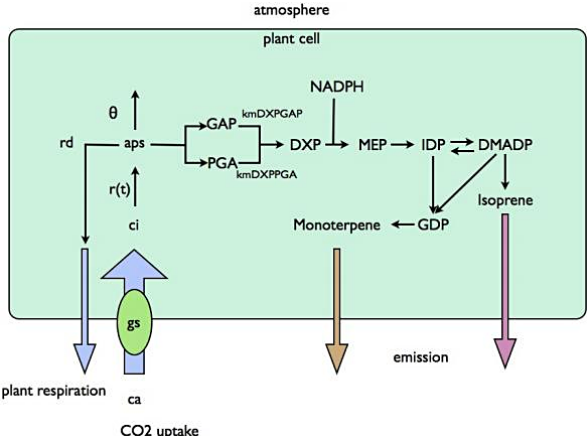
Figure 1. Reaction pathways of the SIM–BIM emission model. Here, C a is CO 2 concentration in the air; C i is intercellular CO 2 concentration; g s is stomatal conductance; A ps is assimilated car- bon pool; r(t) is photosynthesis rate as a function of light; r d is dark respiration rate; θ is the fraction of carbon used in a plant’s metabolism; kmDXPGAP and kmDXPPGA are Michaelis–Menten reaction coefficients; GAP is glyceraldehyde-3-phosphate; PGA is 3-phosphoglyceric aldehyde; DXP is 1-deoxy-D-xylulose 5- phosphate; MEP is 2-C-methyl-D-erythritol 4-phosphate; NADPH is nicotinamide adenine dinucleotide phosphate; IDP is isopentenyl diphosphate; DMADP is dimethylallyl diphosphate; GDP is geranyl